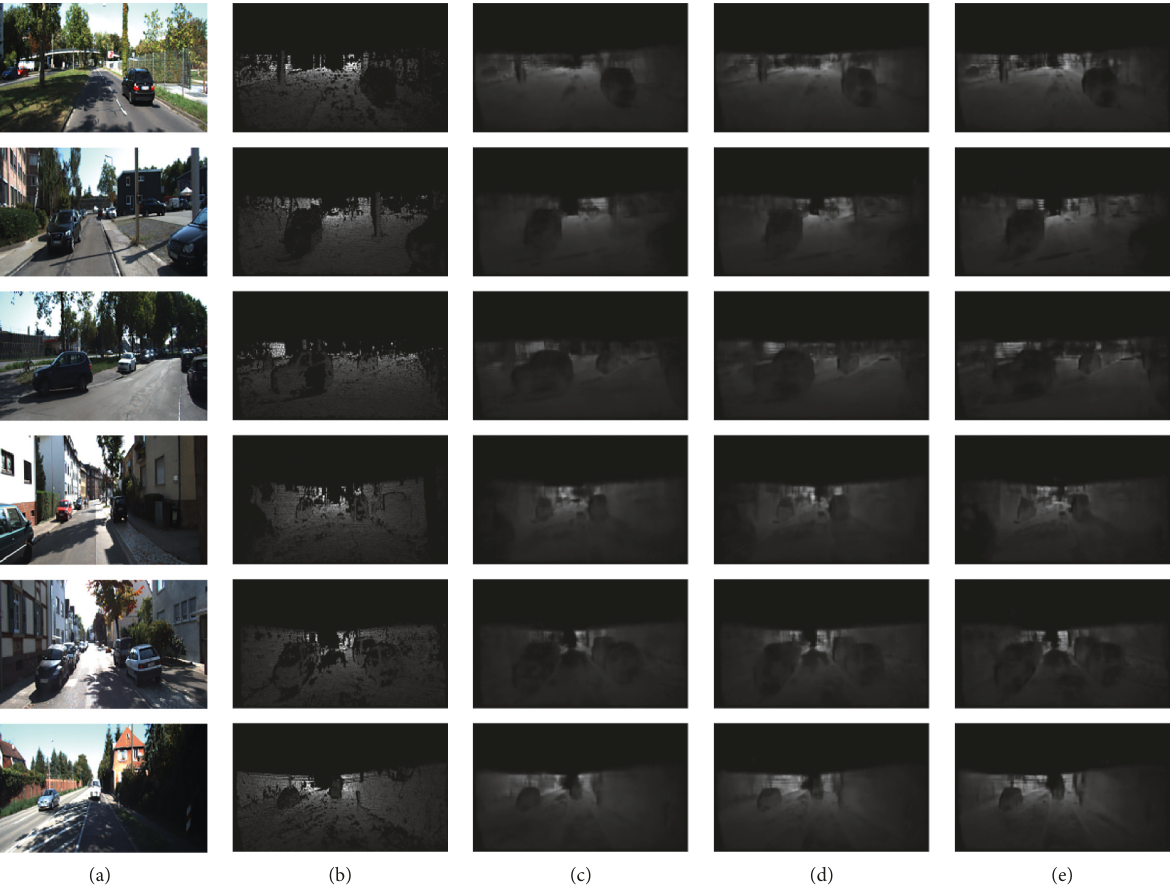
Figure 4: Experimental results chart. (a) RGB image, (b) ground truth, (c) depth prediction map of Proposed1, (d) depth prediction map of Proposed2, and (e) depth prediction map of